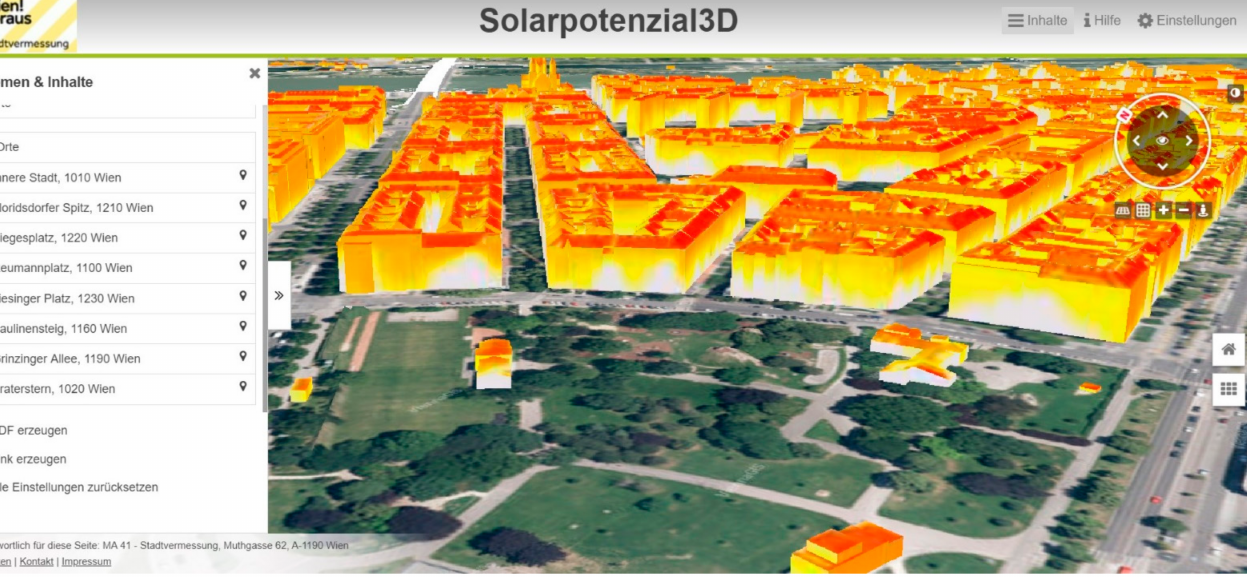
Figure 9. Example of the solar cadastre for both roofs and façades of buildings—The Wien Solarpotenzial3D. Source: own study based on [102].